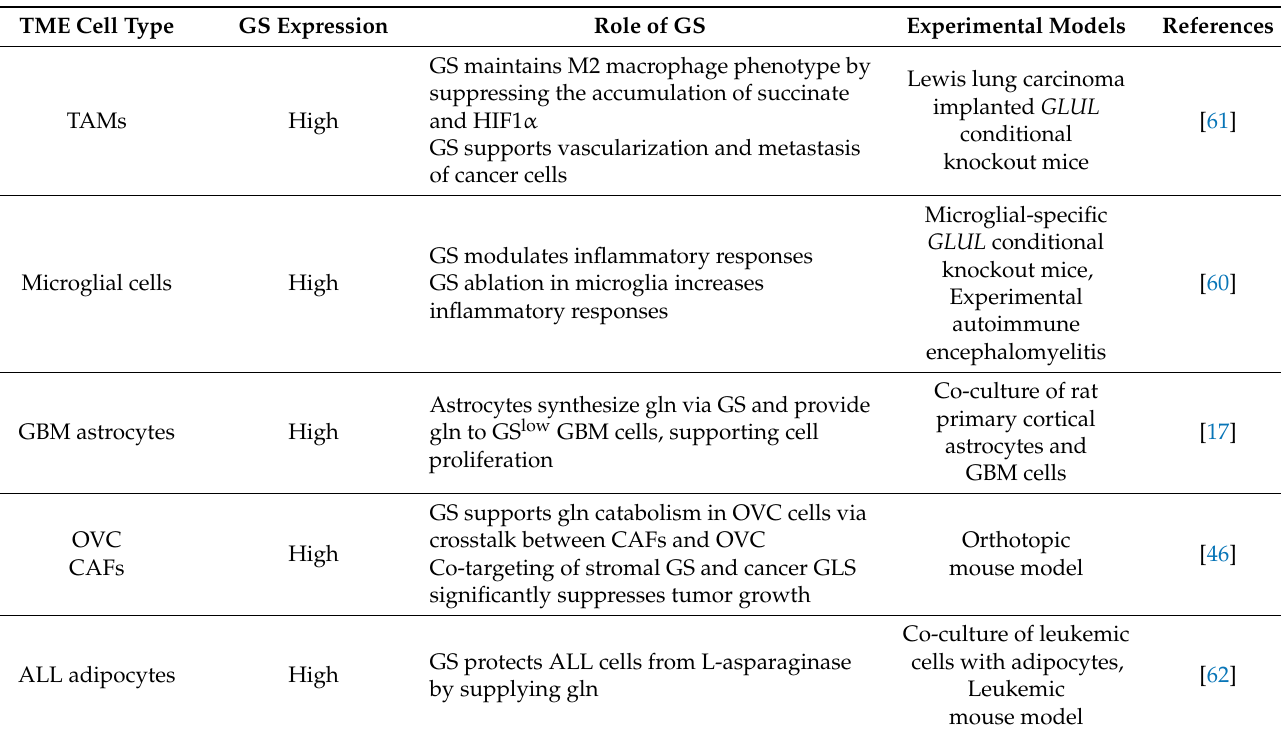
Table 2. Diverse roles of GS in